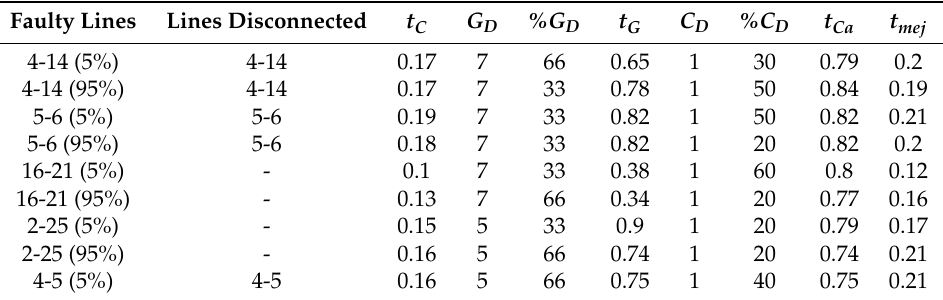
Table 2. Transient stability prediction with relative angles for different faults.